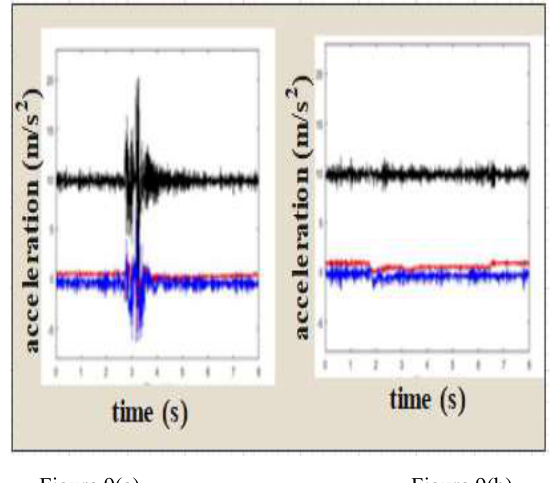
Figure 9 . Plotted image of road surface without potholes.